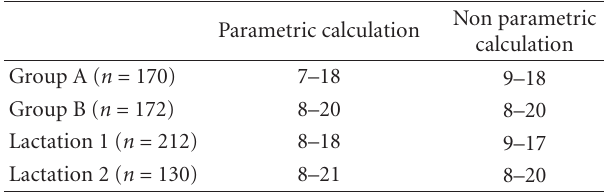
Figure 4: Distribution of all analysed serum copper (a) and zinc concentrations (b) in the two lactations (1 and 2). Table 5: Calculated reference ranges for zinc ( μ mol/L) in depen- dence on the di ff erent feeding groups (A and B) and lactations (1 and